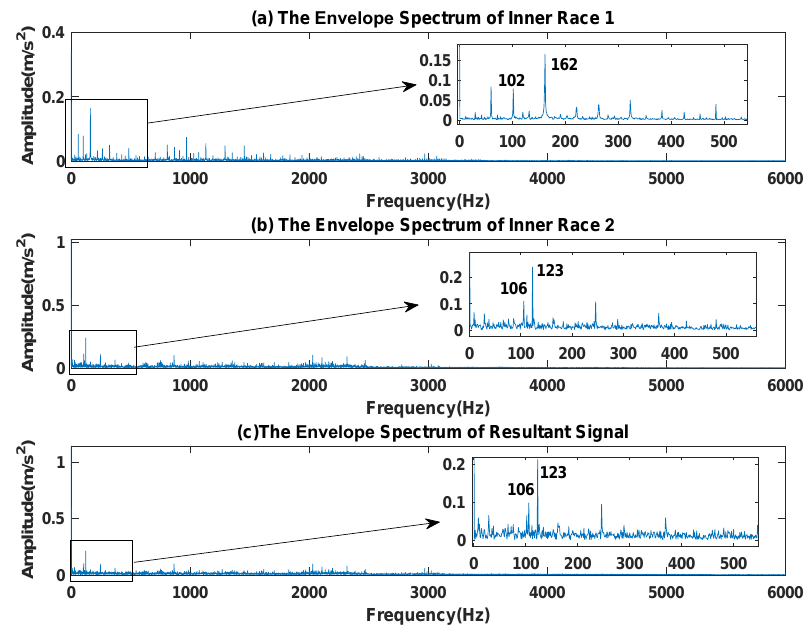
(c)The Envelope Spectrum of Resultant Signal